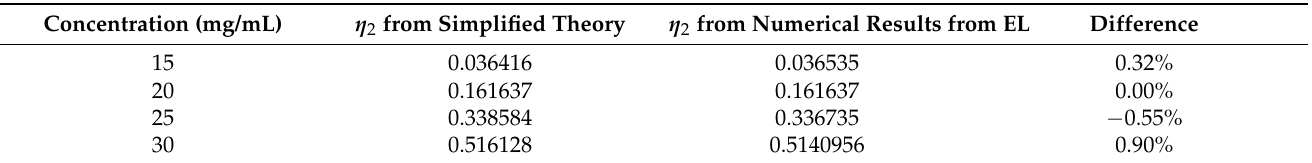
Table 5. Comparison of dimensionless theoretical values of η 2 and calculated from the EL at different concentrations.